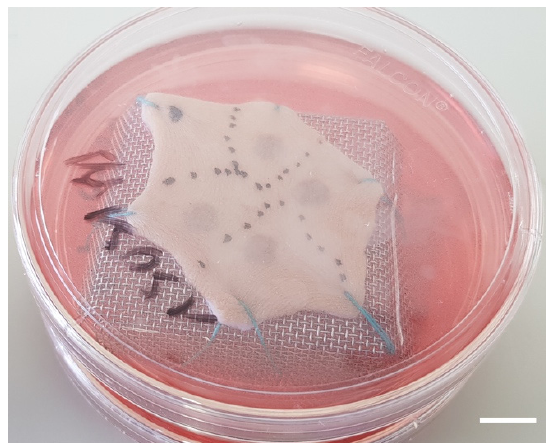
Figure 10. Picture of a human skin explant 12 h after experimental burn, before skin debridement (scale bar: 1 cm).